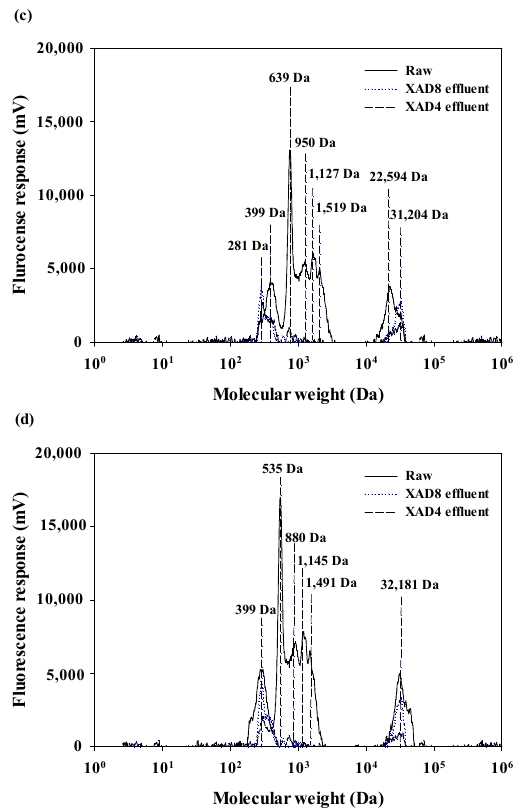
Figure 4. Changes in the molecular weight (MW) distribution of AHA through XAD 8 and 4 resins with ( a , b ) columns and ( c , d ) solide-phase extraction (SPE) devices: ( a , c ) aromatic substance; ( b , d ) protein-like substance.